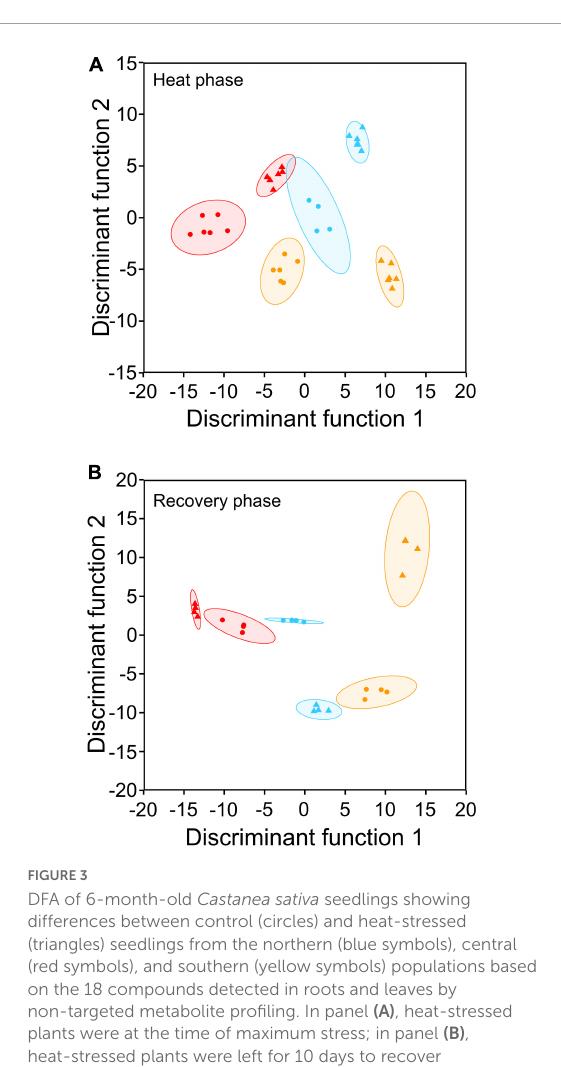
FIGURE4 PCA of 6-month-old Castanea sativa seedlings showing differences between control (circles) and heat-stressed (triangles) seedlings at heat (A) and recovery (B) phases from northern (blue symbols), central (red symbols), and southern (yellow symbols) populations according to the physiological variables included in Figure 5 . In panel (A) , heat-stressed plants were at the time of maximum stress; in panel (B) , heat-stressed plants were left for 10 days to recover ( Supplementary Figure 1 ). In panel (A) , the 10 variables contributing most to the PC1 and PC2 axes were leaf starch (28.4%), leaf soluble sugars:starch ratio (27.9%), root proline (12.1%), whole plant soluble sugars:starch ratio (8.1%), root flavonoids (3.1%), root ortho-phenols (2.8%), leaf proline (2.6%), root phenols (1.9%), instantaneous water use efficiency (1.5%), and root biomass